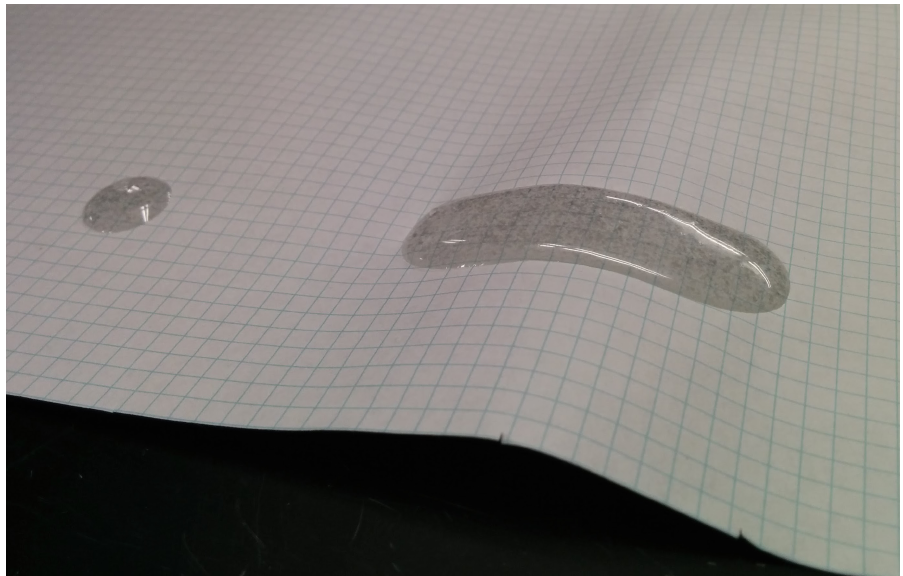
Figure 6. Sample of a flexible adhesive applied to